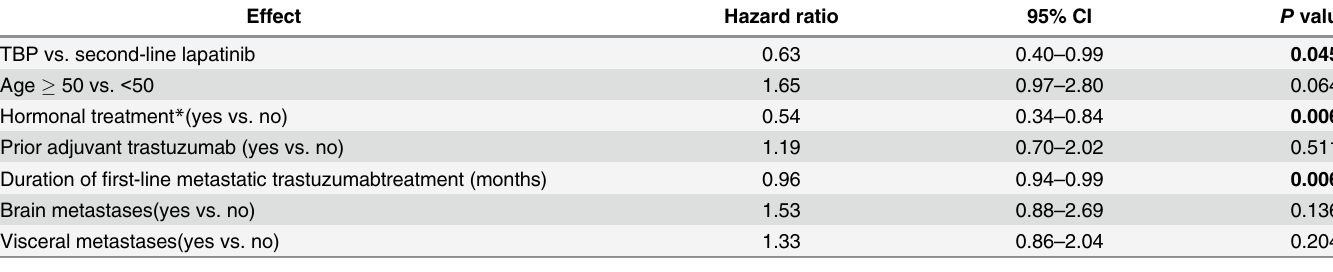
Table 4. Overall survival hazard ratio, multivariate Cox regression